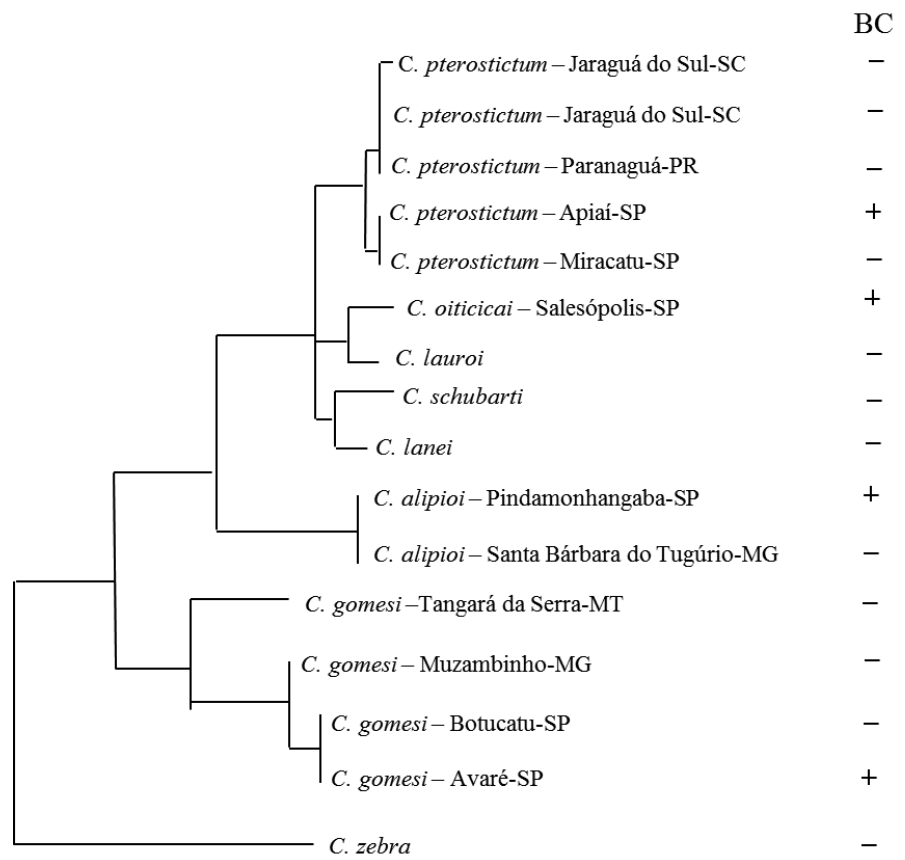
Figure 1. Characidium phylogeny adapted from Pansonato-Alves et al. (2014) and positioned for the population analyzed here. BC: presence or absence of B chromosomes.